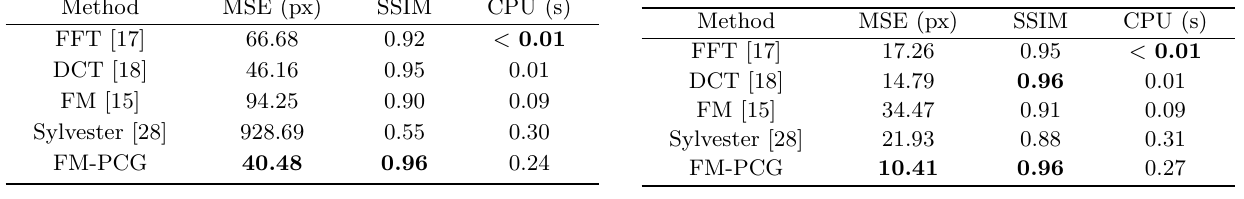
Fig. 15 Results of (a) improved FM and (b) improved FM-PCG methods introducing a smoothness constraint on the outliers. The corresponding MSE maps (c) and (d) show that errors due to the outliers are much reduced. Table 18 Results of the improved methods on the same dataset as in Table 17. All MSE are significantly